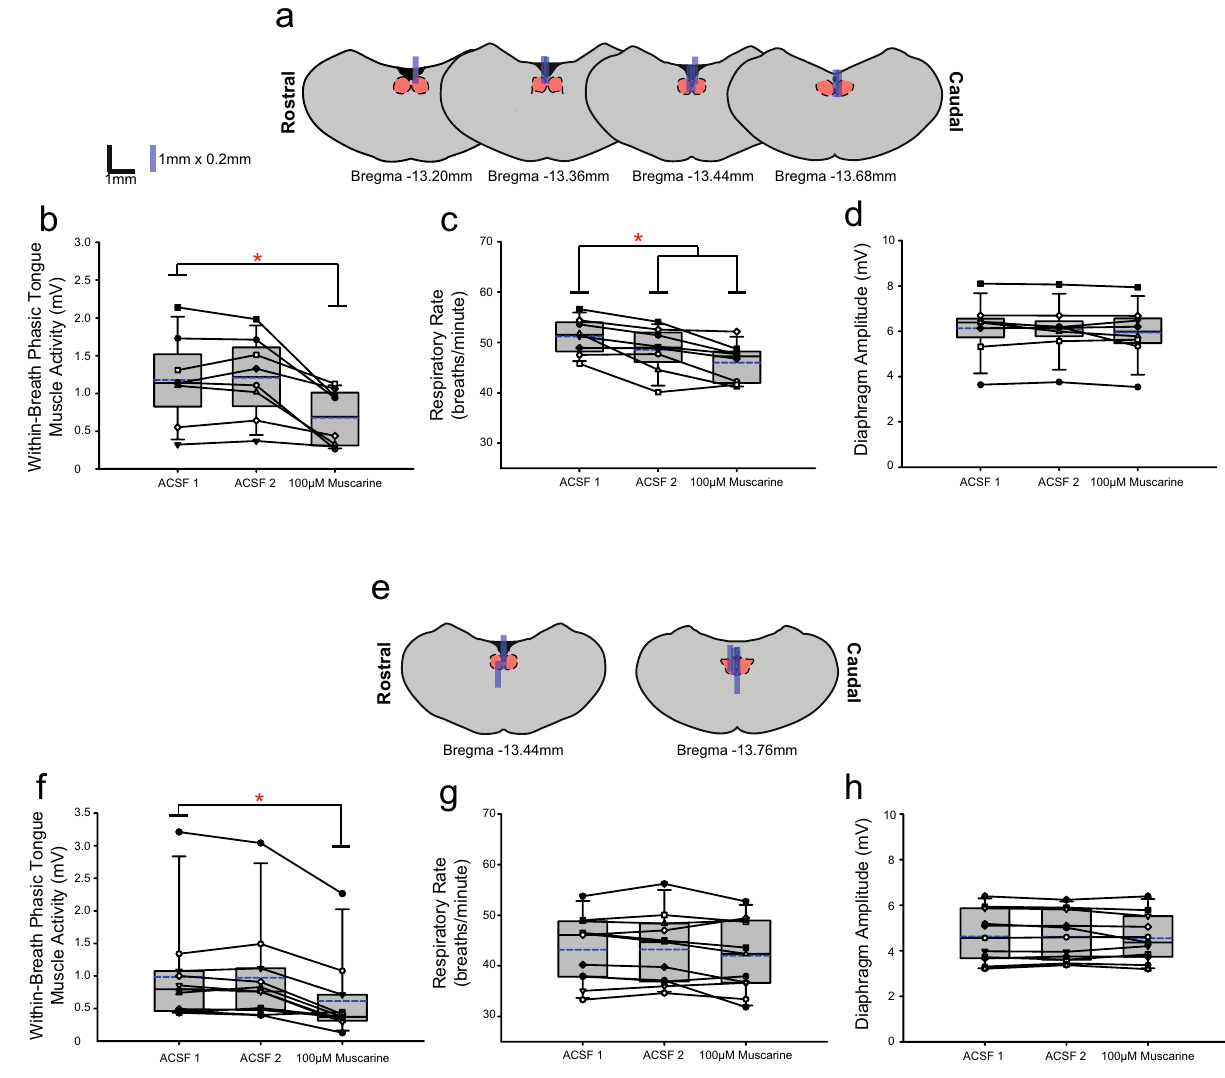
Figure 10. Group data from Protocol 3.1 : Microperfusion of 100 μM muscarine into the HMN (top panels: male, n = 8; bottom panels: female, n = 11). Schematic representations of coronal sections of medulla illustrating the distribution of probe sites across all experiments ( a , e ). Drawn to scale, the blue rectangles represent reconstruction of the sites of the microdialysis probes; overlap obscures some of the individual probe sites. Box and whisker plots show individual and group data (median [dashed line], mean [solid line] and 25th and 75th percentiles) for within-breath phasic tongue muscle activity ( b , f ), respiratory rate ( c , g ), and diaphragm amplitude ( d , h ). Each animal is indicated by a different symbol. *, indicates p < 0.05 compared to baseline ACSF Other respiratory parameters. Some decreases in respiratory rate were observed in three of the six experiments encompassing Protocol 3.2a‑d (indicated by the symbol ‘*’ in Figs. 11, 12, 13 and 14, each p ≤ 0.033, post hoc Dunnett’s test after one-way ANOVA-RM indicated significant differences between groups, each F ≥ 7.86 and each p ≤ 0.005). No changes were observed in the other three protocols. As noted above, such effects on respira- tory rate also similarly occurred in the ACSF time control experiments (Fig. 7). There were no effects of the interventions on diaphragm amplitude across Protocols 3.2a‑d (each F ≤ 1.52 and all p ≥ 0.122, one-way ANOVA-RM, Figs. 11, 12, 13 and 14). Relative efficacy of interventions at the HMN to reduce muscarine‑induced tongue motor suppression. Within‑breath phasic tongue muscle activity. Figure 15 shows group data comparing within- breath phasic tongue muscle responses across all protocols with muscarine-induced inhibition, effects of the an- tagonists and the respective time-controls. There was a significant effect of the interventions across the different protocols on tongue motor activity (F 8,72 = 8.17, p < 0.001, one-way ANOVA). Within-breath phasic tongue muscle activity in the presence of muscarine at the HMN was significantly lower compared to when either atropine or scopolamine were co-applied at the HMN (p = 0.027 and p < 0.001,